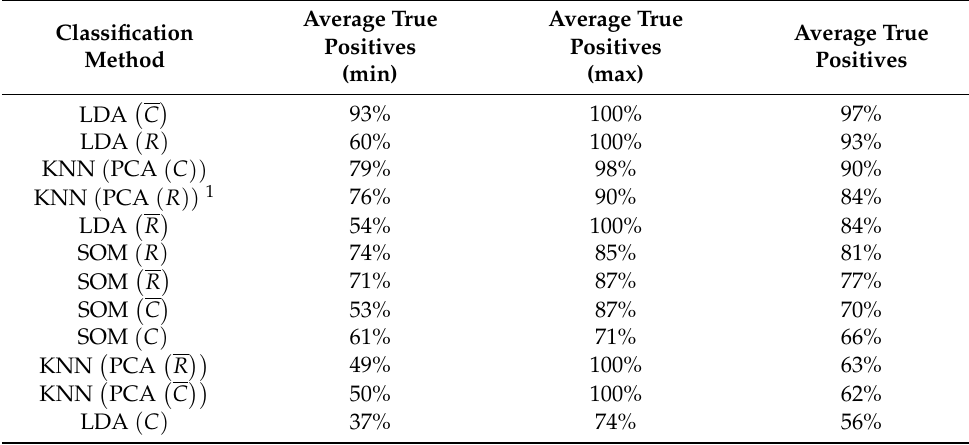
Table 6. Summary of the classifiers performance assessed in this